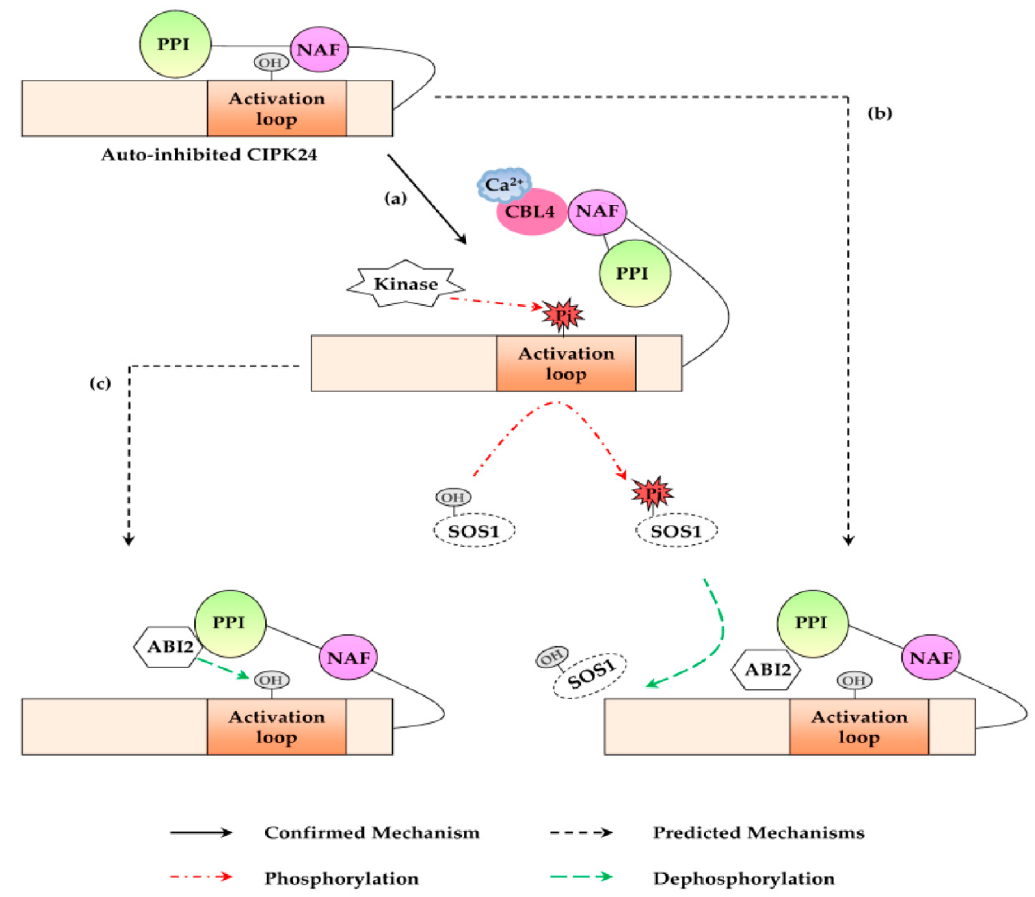
Figure 3. Mechanism of Calcineurin B-like protein 4 (CBL4)-CBL–interacting protein kinase (CIPK24) signaling pathway. (a) The Ca2+-binding CBL4 interacts with the NAF motif of CIPK24 and changes the conformation of CIPK24. CIPK24 exposes its activation loop and then is phosphorylated by an unknown upstream protein kinase. Activated CIPK24 phosphorylates and stimulates salt overly sensitive 1 (SOS1), subsequently. (b) Abscisic acid-insensitive 2 (ABI2) binds to the phosphatase interaction (PPI) domain of CIPK24 and dephosphorylates SOS1 which was phosphorylated by CIPK24. (c) Activated CIPK24 is dephosphorylated by ABI2, and its activity is inhibited. (Adapted from Mao et al. (2016)).